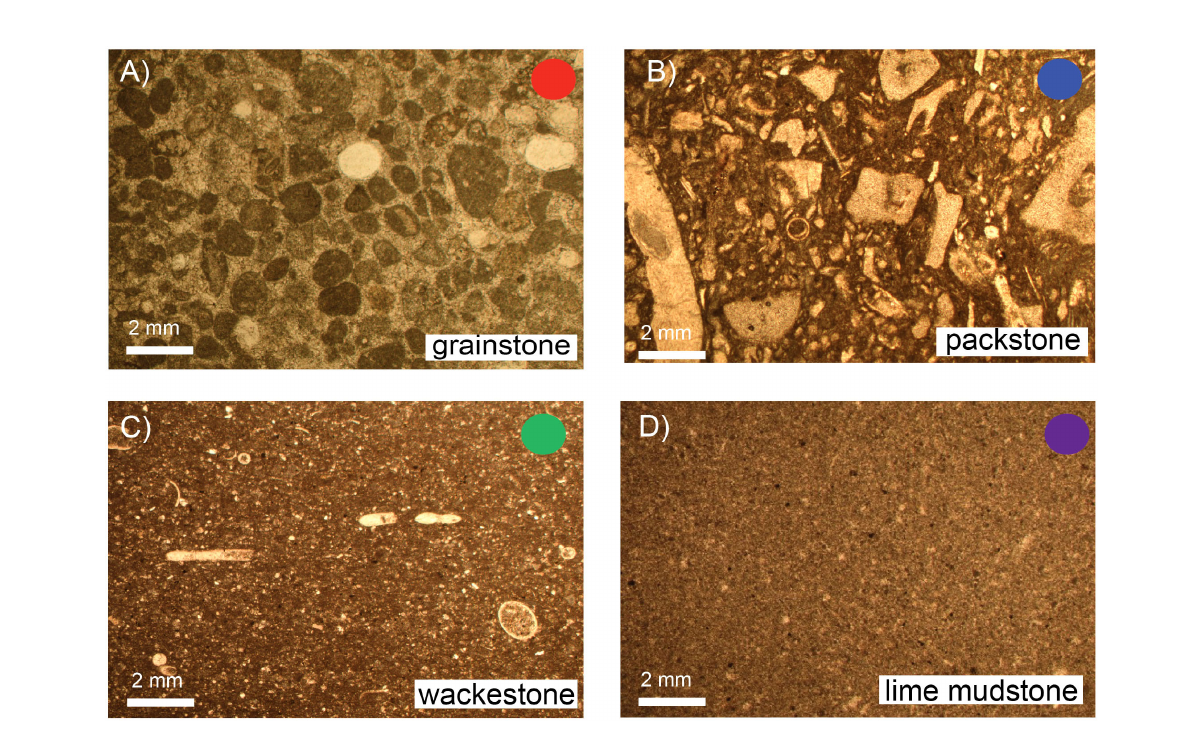
FIGURE 2 Thin section photographs of the main four lithologic groups identi fi ed in the composite Great Basin section of Nevada. Photos were taken under plane-polarized light. The colored solid circles are consistent with the colors shown in Figures 3 – 6 and S2. From (A – D) , lithologic transitions are from coarse grained to fi ne grained and depositional environments transition from upper shoreface to offshore environments. Note abundant early marine cements in the grainstone of (A)